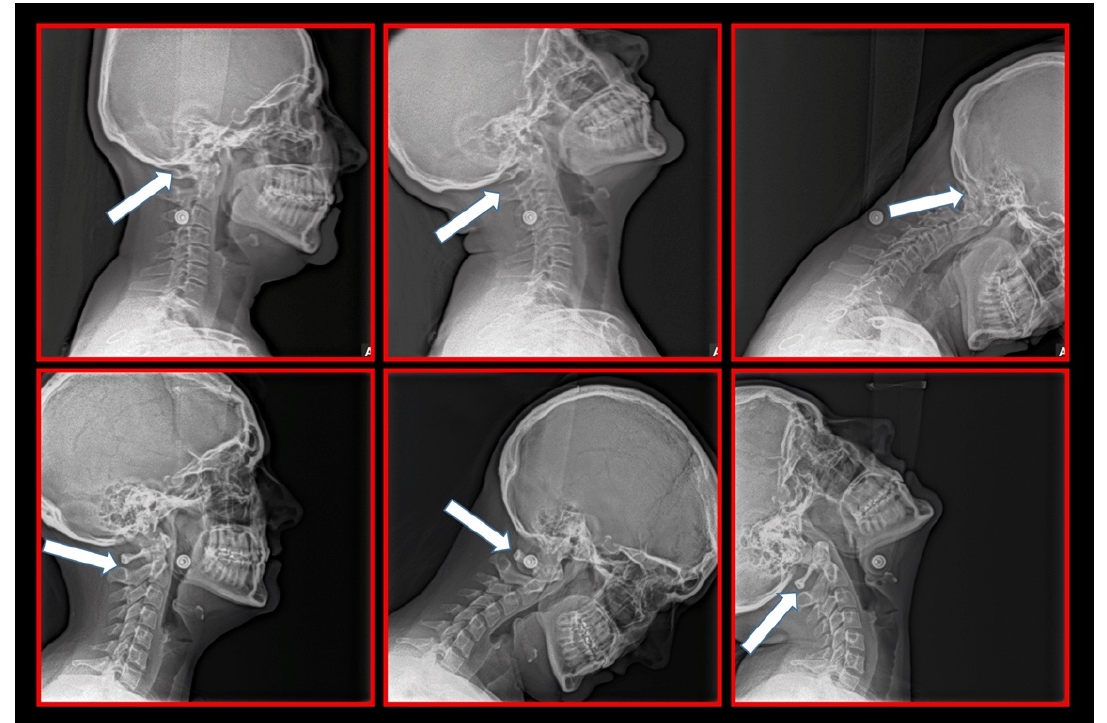
Figure 14. Relations among the occiput, C 1 and C 2 vertebrae. Upper row: Static atlas on the occiput causing mechanical compression and irritation of the C 1 nerve root, causing occipital supraorbital pain. Lower row: Static atlas on the axis causing additional complaints at the level of the C 2 nerve root, including unilateral craniofacial pain.